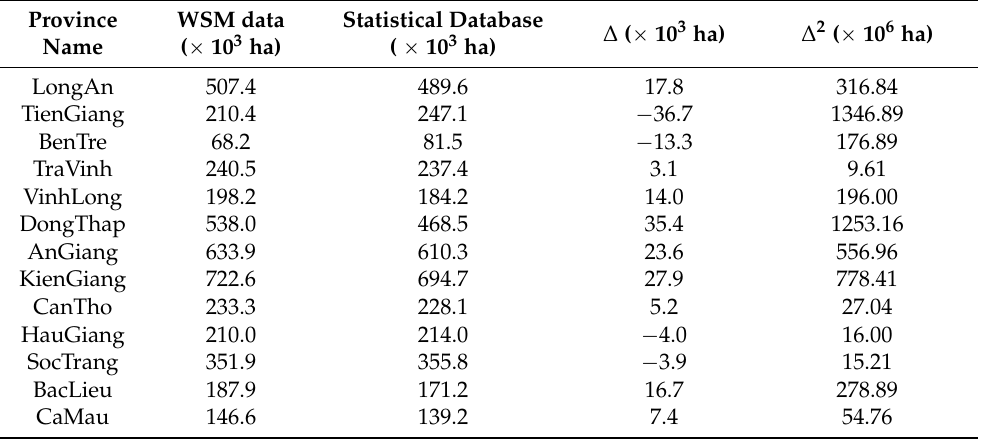
Table 3. Average planted area of rice by province (in ha) for all seasons in five-year period (2007 ´ 2011) from the statistical database and from the WSM